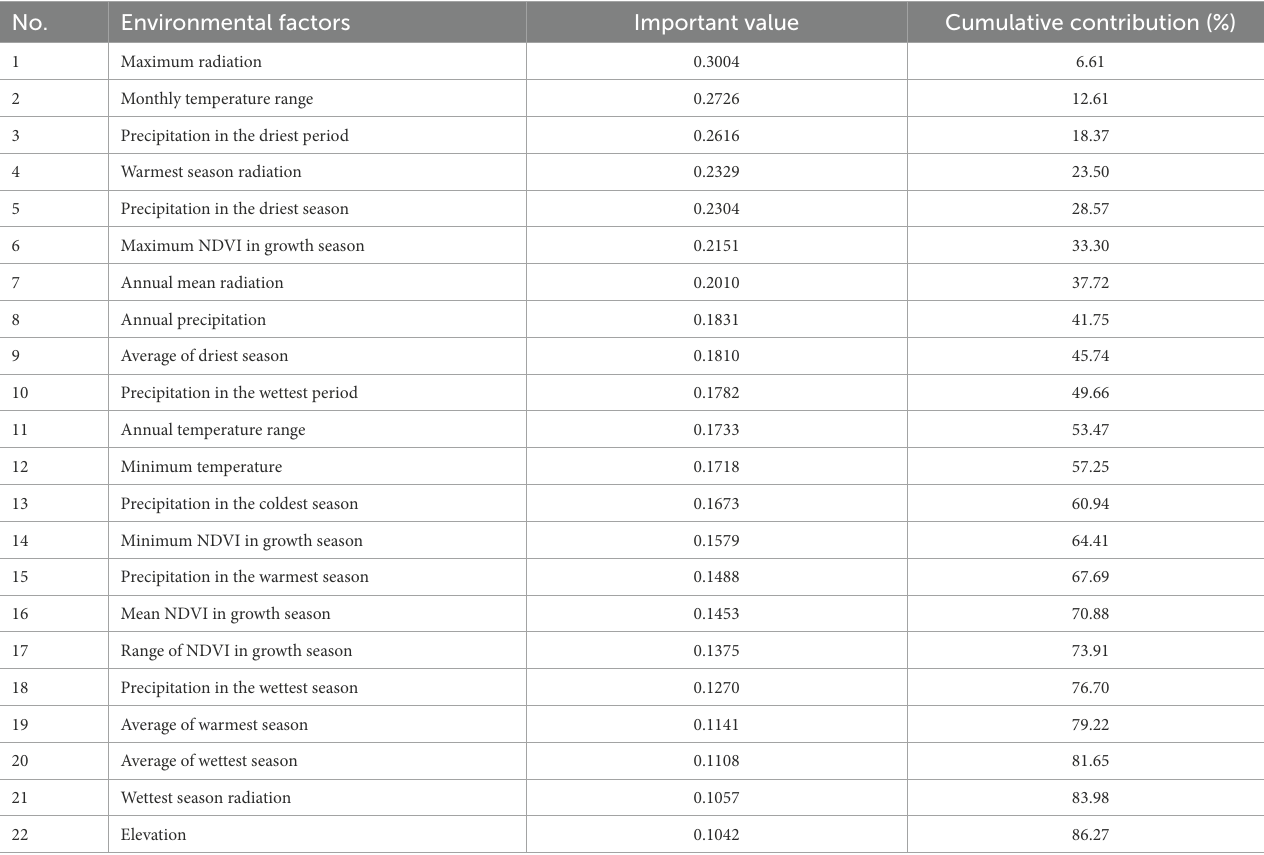
TABLE 1 Influencing factors for Kobresia pygmaea